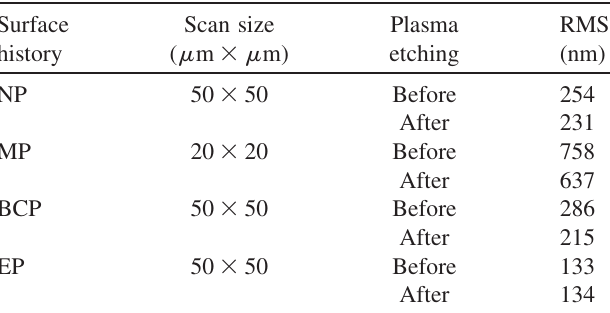
PLASMA TREATMENT OF BULK NIOBIUM SURFACE FOR . . TABLE II. RMS measurement dependence on surface prepa- ration history. Surface